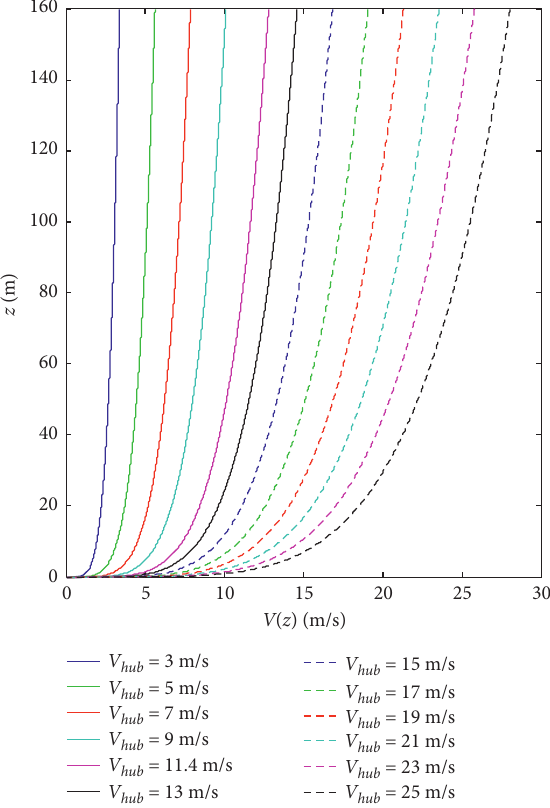
Figure 3: The distribution of normal mean wind speed with different height.